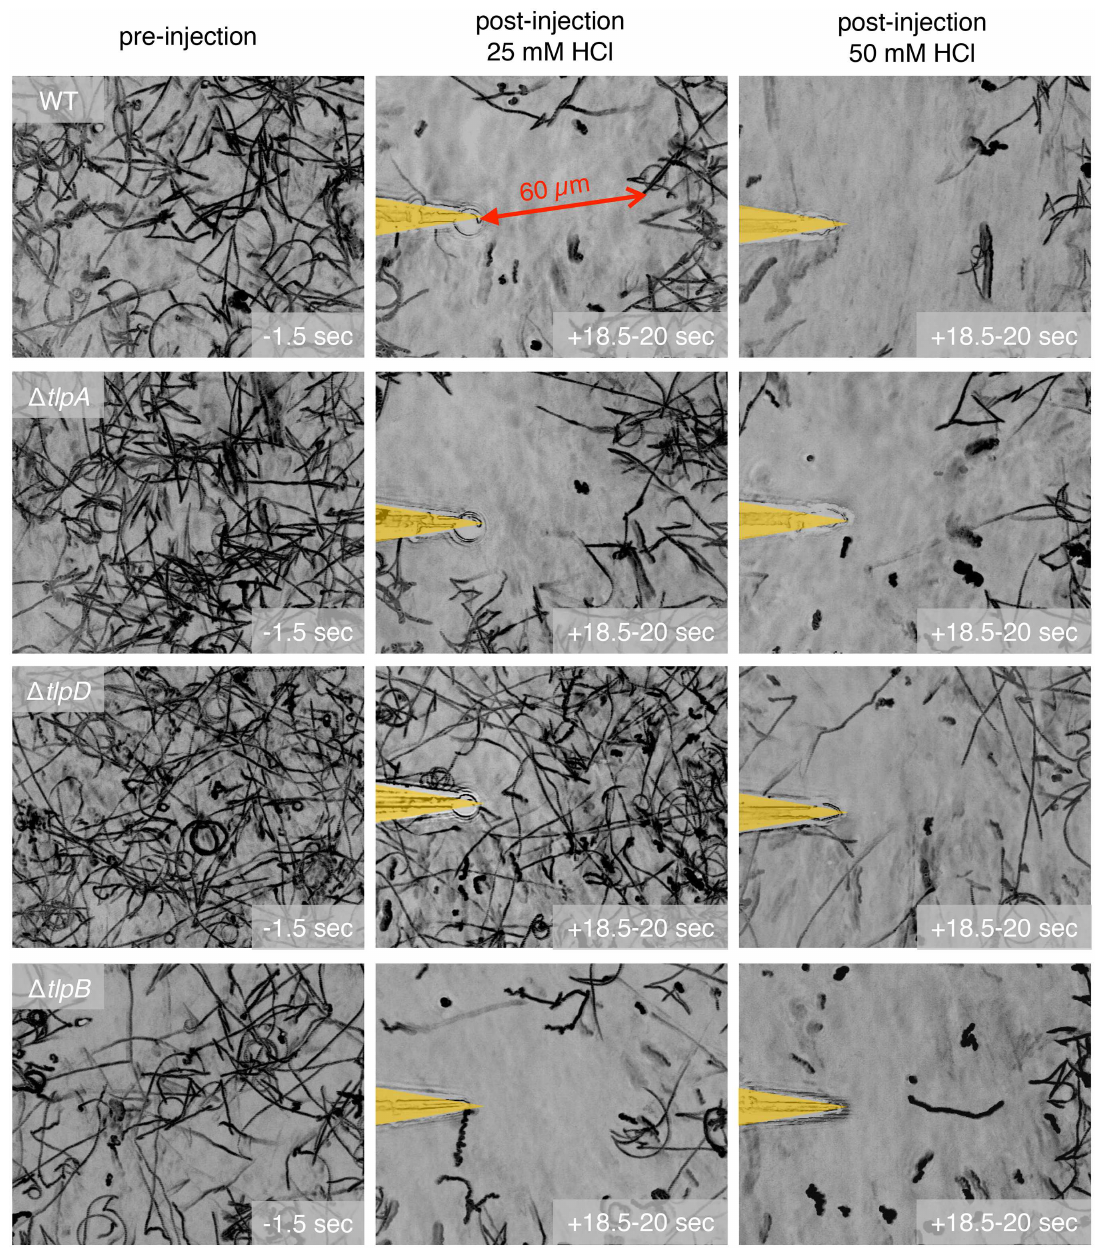
Fig 3. TlpD is more sensitive to a hydrochloric acid gradient than TlpA. Still images of bacterialmotility traces (lasting 1.5 seconds) of wild-type H . pylori vs. Δ tlpB vs. Δ tlpA vs. Δ tlpD before (panelsin left column)and after exposureto a gradientof either 25 mM (panelsin middlecolumn)or 50 mM hydrochloric acid (panels in right column). The positionsof the needletips are marked in